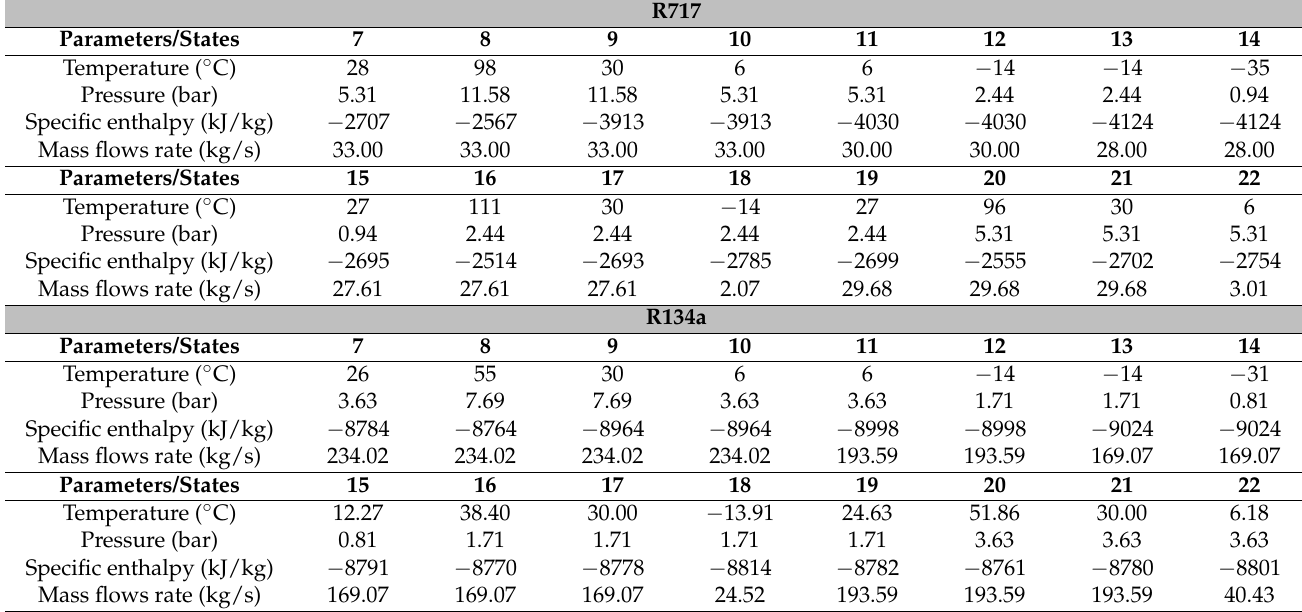
The flow diagram of the precooled Linde–Hampson liquefaction process is shown in Figure 5. The captured CO 2 (stream 1) goes through the two-stage compression process with interstage cooling. Stream 5 is mixed with return stream 13, and stream 6 is further compressed up to 25 bar (stream 7). After cooling and liquefaction (stream 9), CO 2 is then expanded in J-T valve down to the target pressure and separated. Stream 11 is the product stream. For the refrigerant cycle, ammonia (R717) is selected as the working fluid as suggested in [21]. The ammonia stream (stream 14) is compressed by the two-stage compression process in order to achieve the condensation pressure. Stream 18 is then expanded. Stream 19–14 (R717) together with “return” CO 2 stream 12–13 formed so-called “cold composite curve” within 3-flow heat exchanger (HEAT) in order to liquefy the stream of CO 2 , i.e., “hot composite curve”.